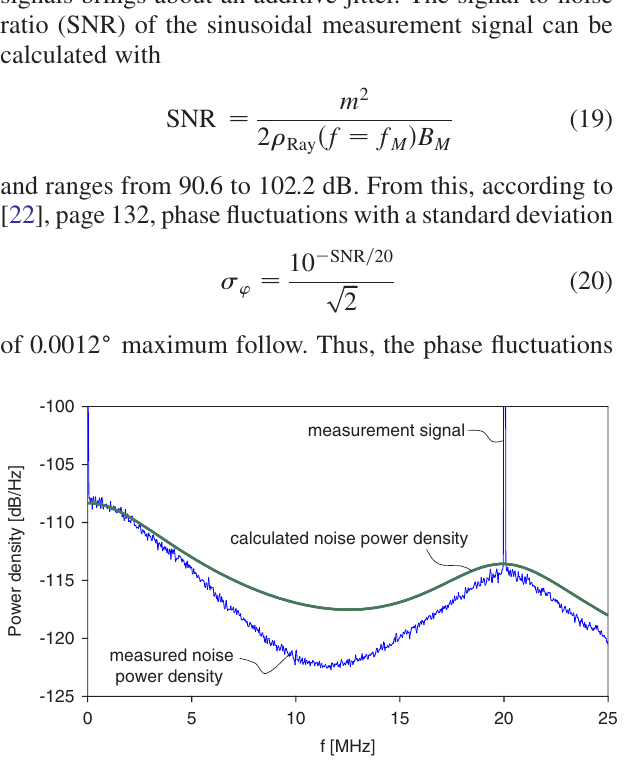
FIG. 12. (Color) Noise in the measurement